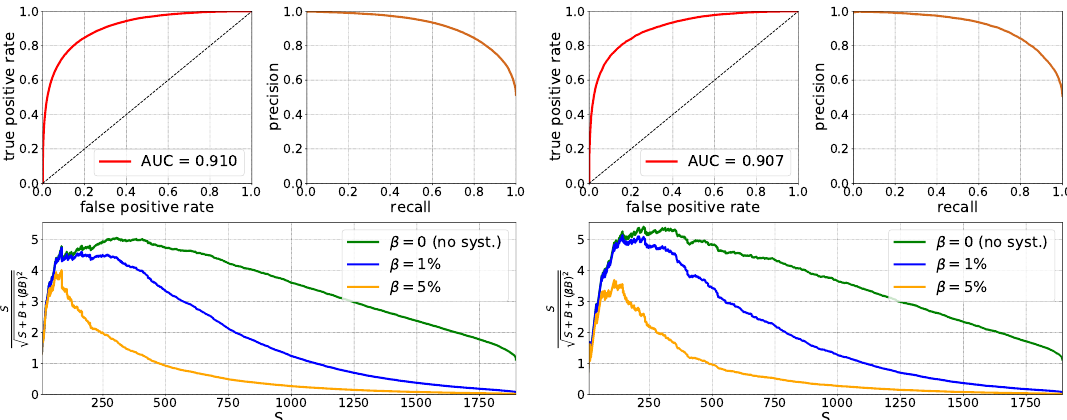
Figure 8 . Training (left) and evaluation (right) outcome of our BDT for the resonant benchmark R 750 350 25, using a fat-jet radius of R = 0 : 6. The lower panels show the signi(cid:12)cance (cid:6) as a p function of the expected signal events S for s = 14 TeV and L = 3 ab (cid:0) 1